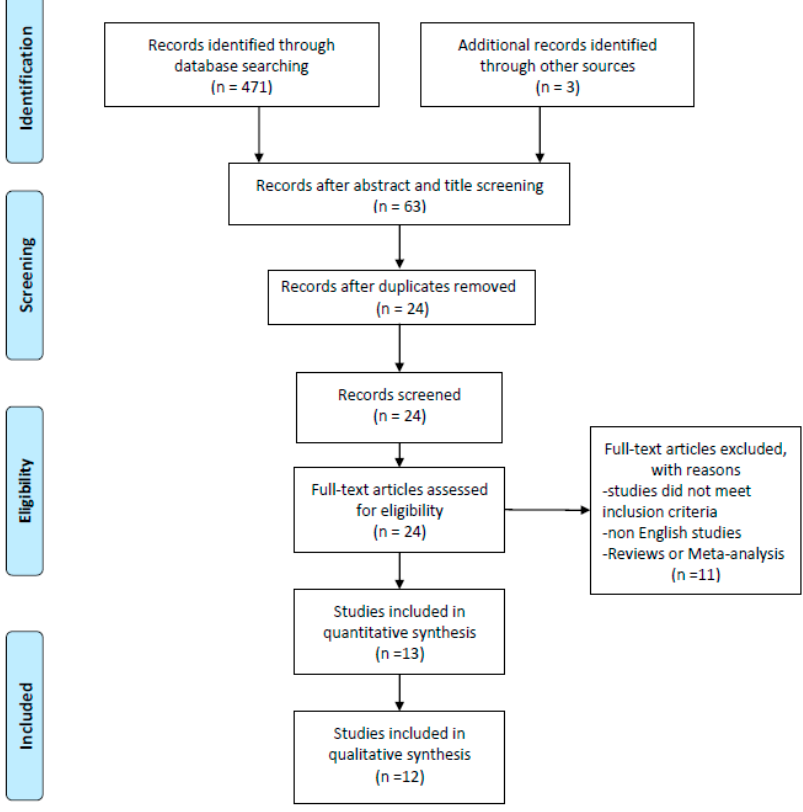
Figure 1. Prisma Flow Diagram